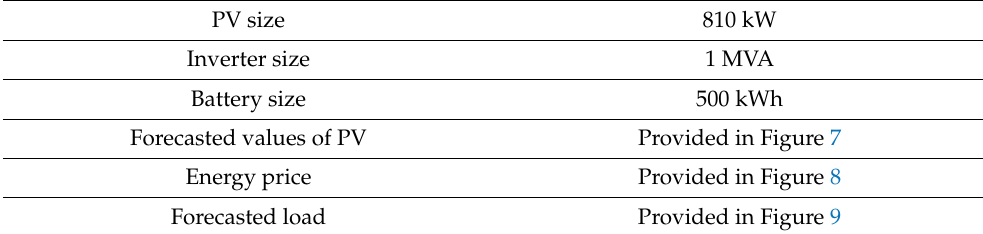
Table 3. Description of the single bus grid-forming VPP.